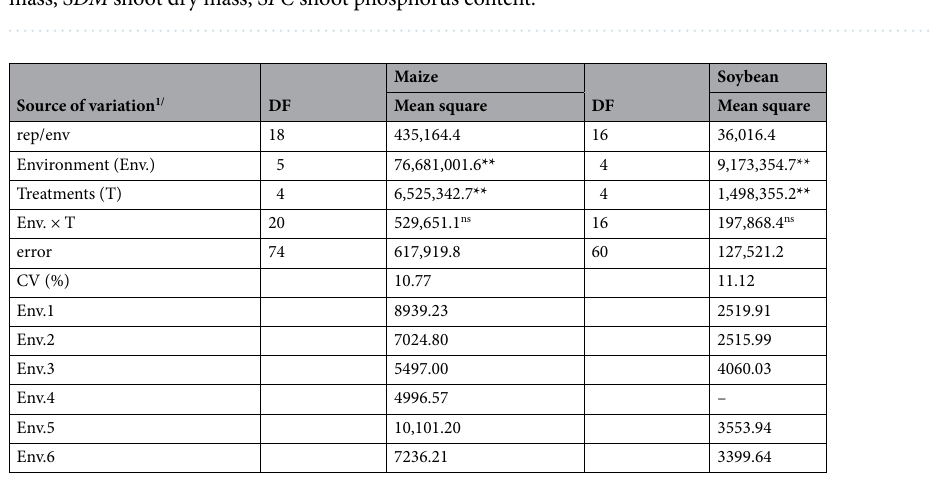
Figure 1. Principal component analysis ( A ) and Pearson correlation ( B ) between traits evaluated in the greenhouse experiment with maize seeds inoculated with different phosphate-solubilizing bacteria. Comparison of the control treatment (without inoculation) with strain 03. SD stem diameter, PH plant height, RDM root dry mass, SDM shoot dry mass, SPC shoot phosphorus content.